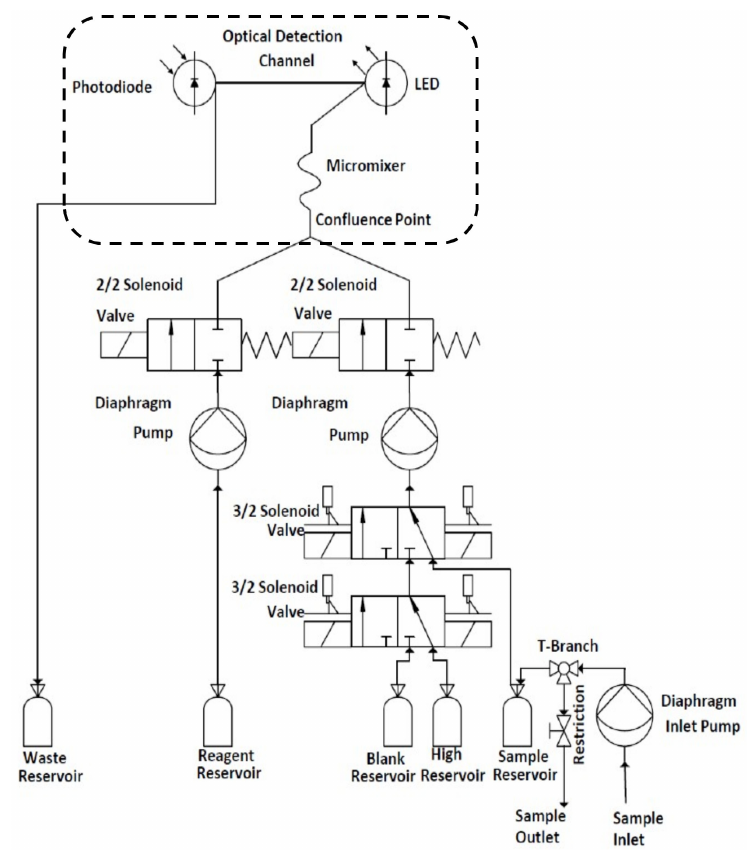
Figure 2. Schematic diagram illustrating the sensing platform fluidic system. The portion including the fluidic chip is within the area bounded by the dashed